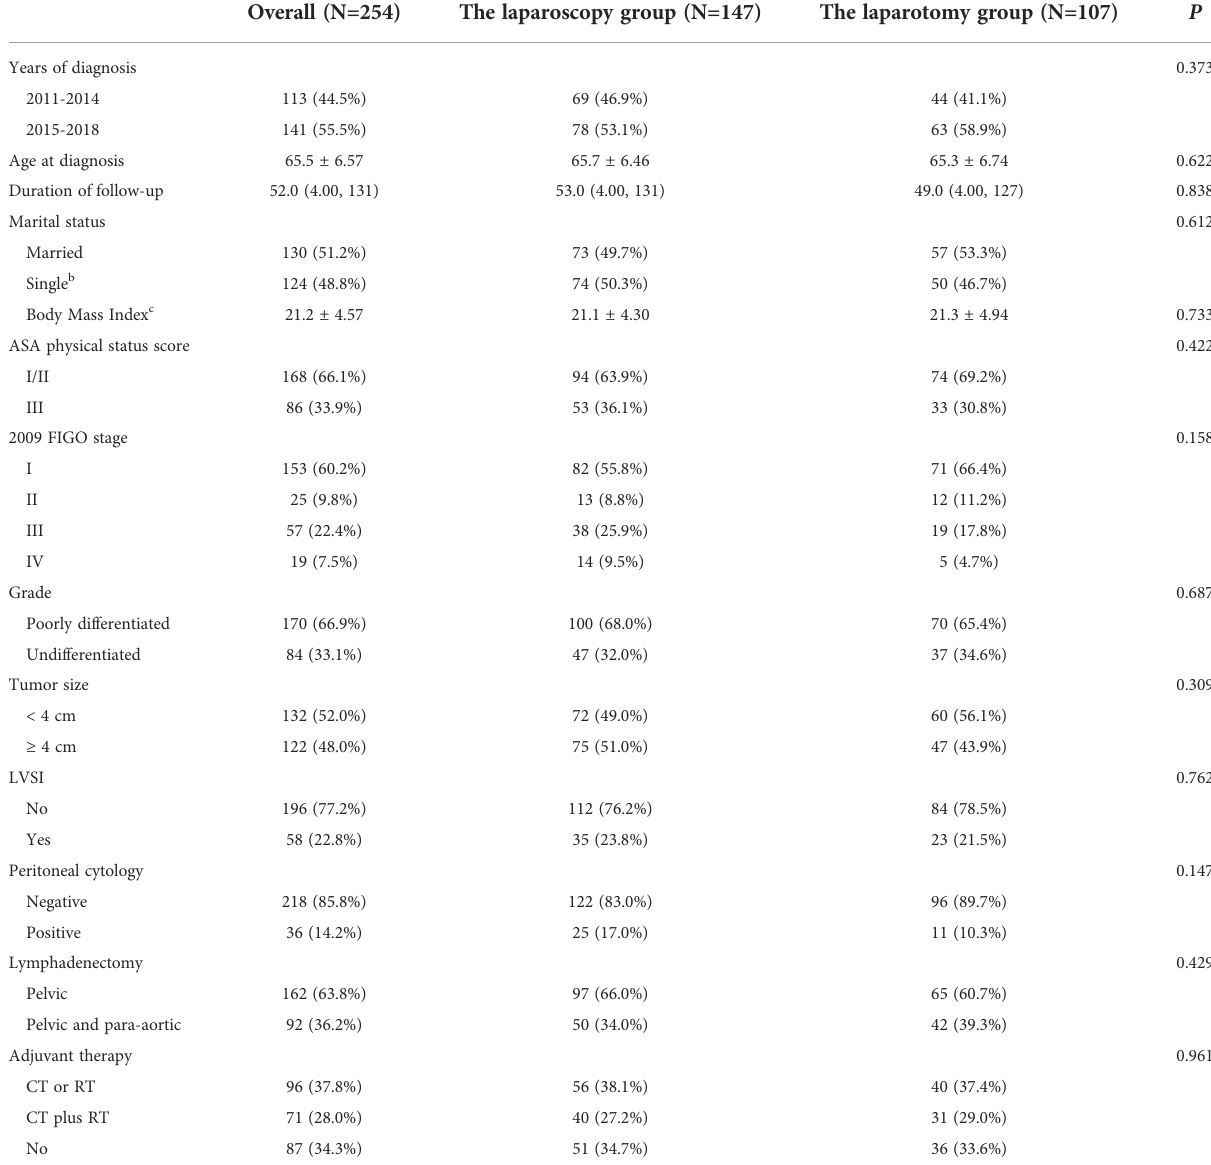
TABLE 1 Characteristics of the study cohort a . Overall (N=254) The laparoscopy group (N=147) The laparotomy group